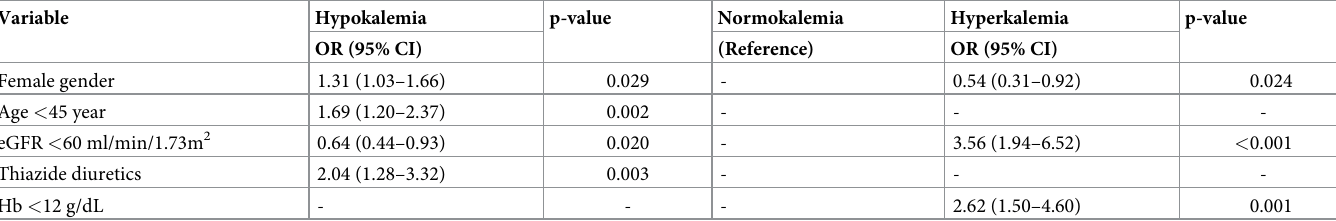
Table 2. Multinomial logistic regression analysis targeting factors associated with dyskalemia.